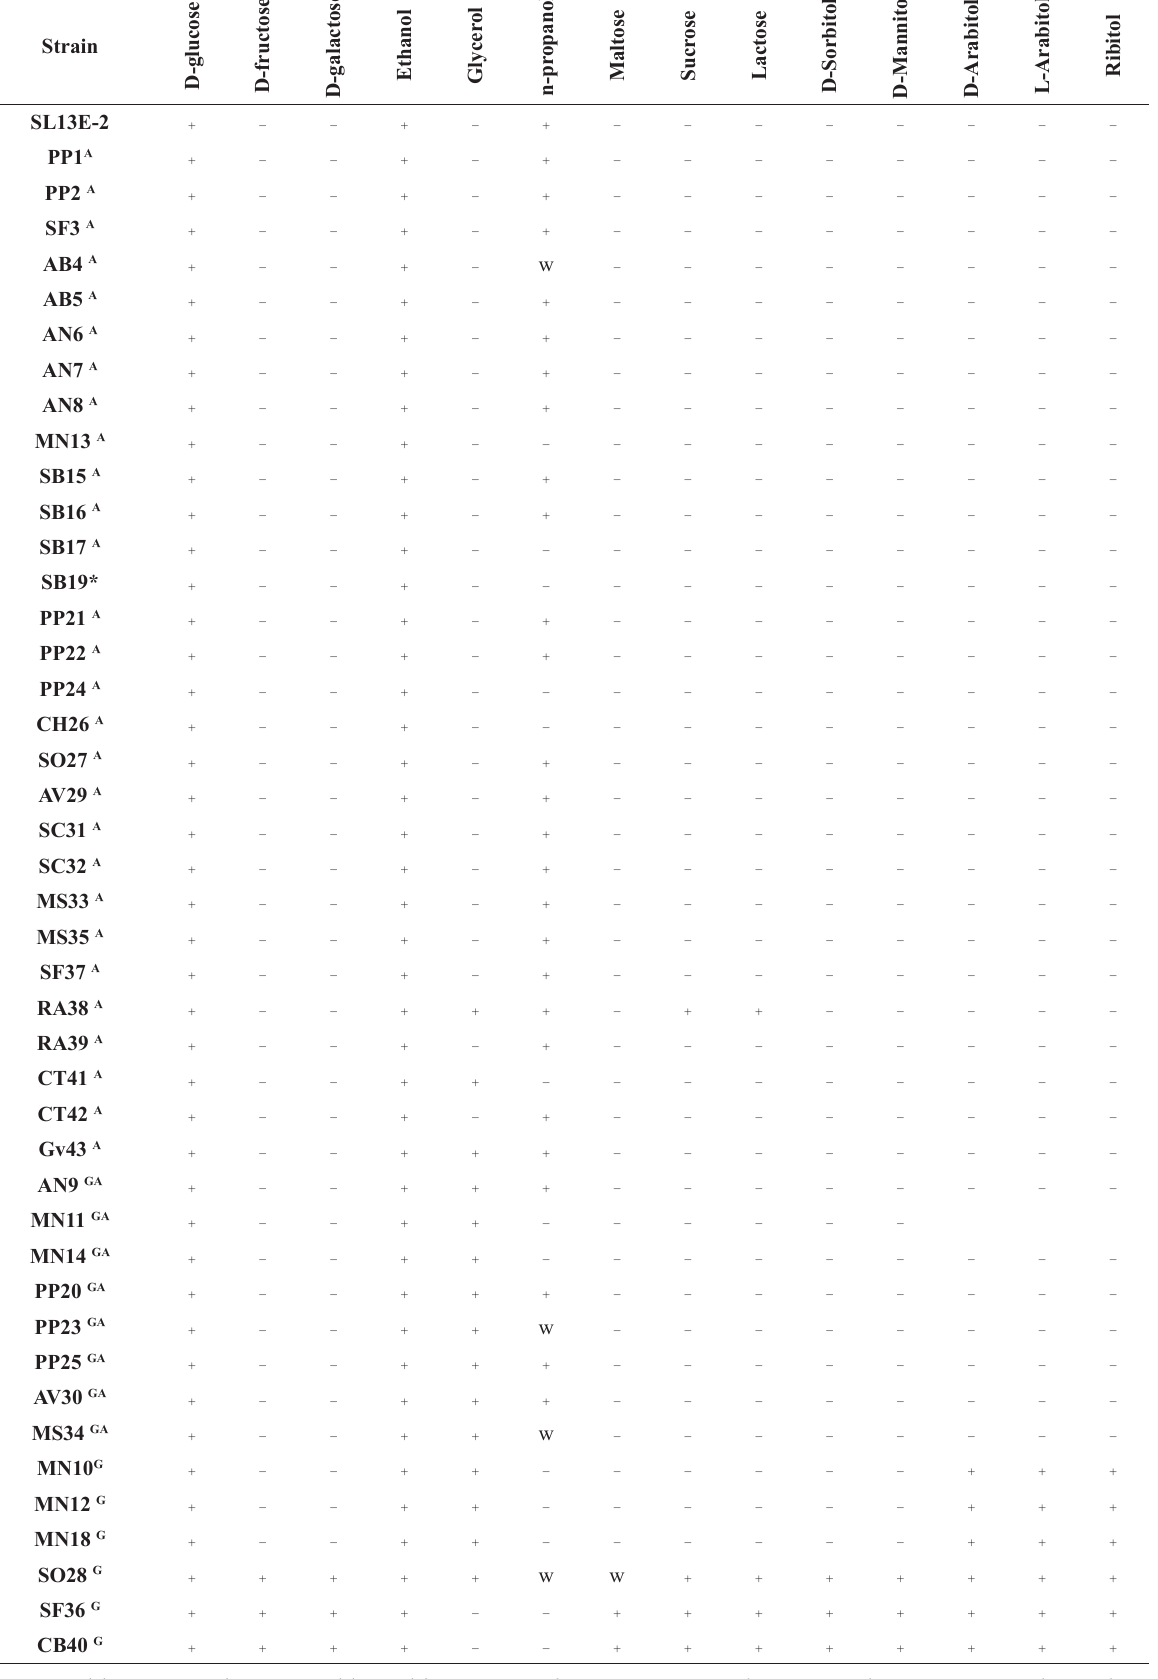
Table 1: Acid production of isolated Acetobacter , Gluconacetobacter and Glucononbacter type strains from different sugar sources.